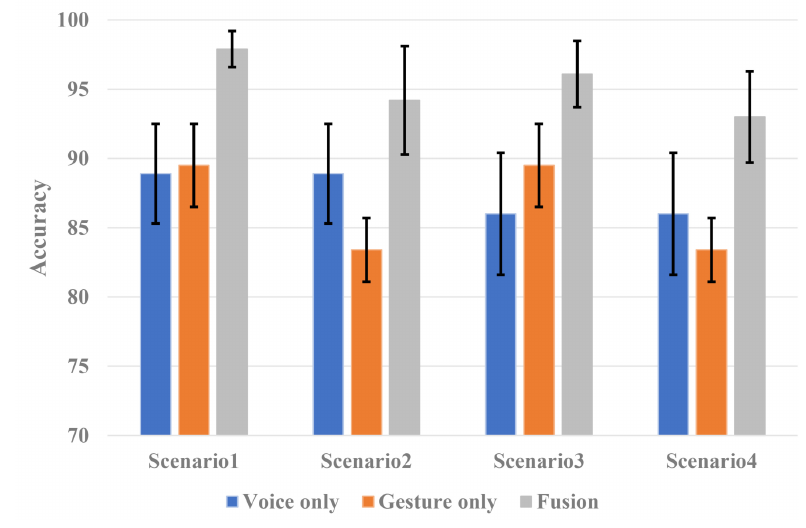
Figure 10. Accuracy of the HVI systems for each scenario.